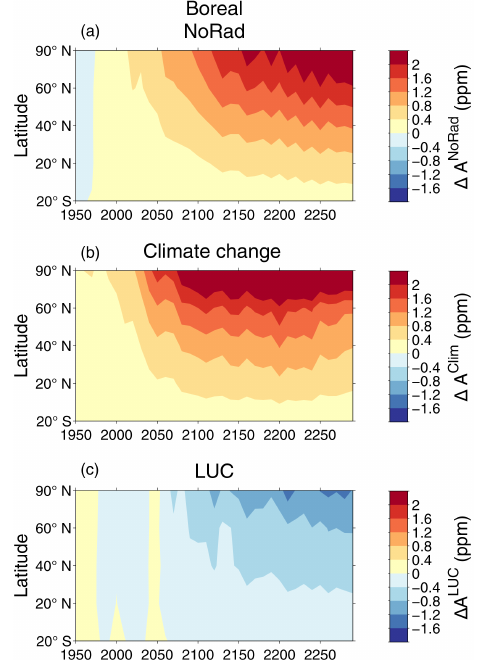
Figure 11. As in Fig. 8 but for (a) CO 2 fertilization + N deposition, (b) climate change, and (c) LUC from boreal regions.